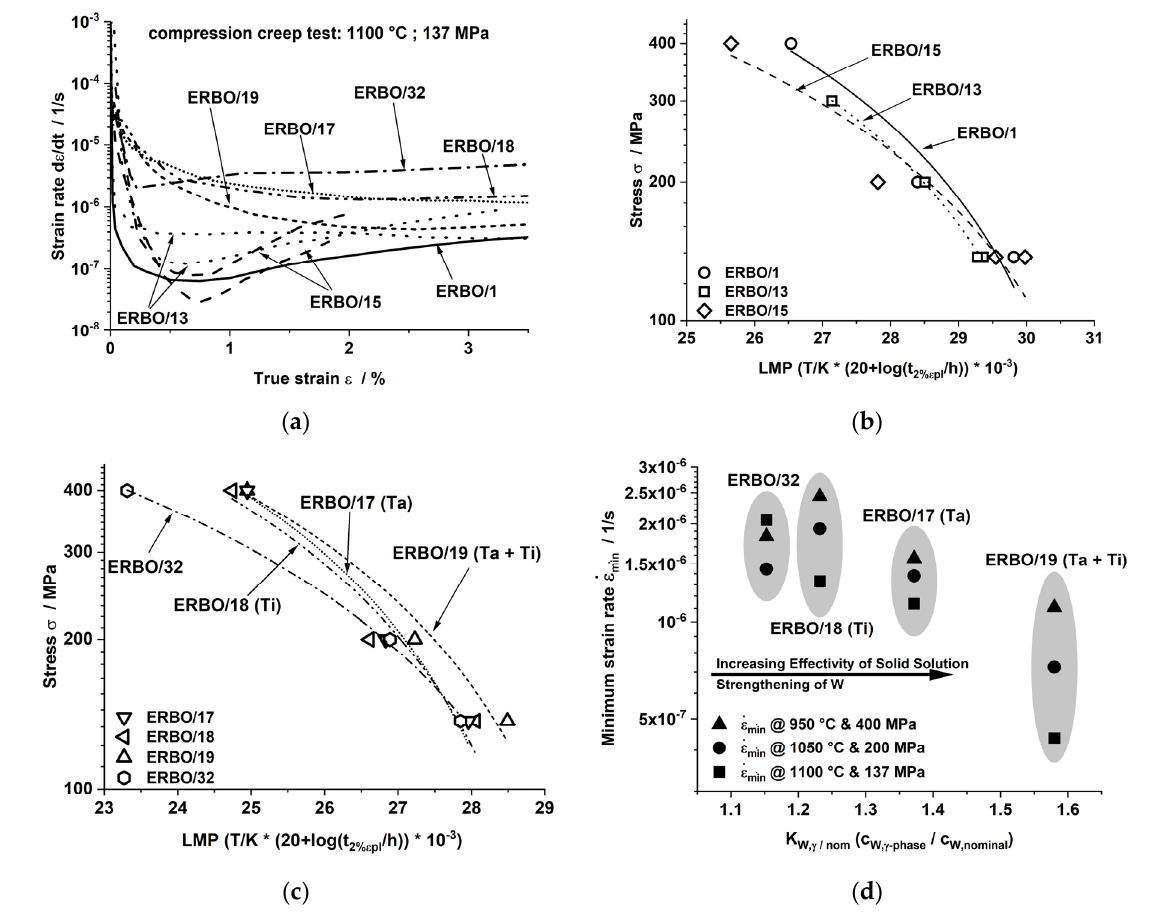
Figure 10: Creep results and their interpretation: ( a ) creep curves showing strain rate vs. true strain for the single-crystalline alloys. ( b ) Larson-Miller Plot of the reference alloy series to compare the creep performance between different creep test conditions, ( c ) Larson-Miller Plot of the model alloy series to clarify the influence of the partitioning efficiency of W and repartitioning efficiency of Ti and Ta on creep properties, which is also shown in ( d ) as a graph of the minimum strain rate as a function of the partitioning efficiency of W.